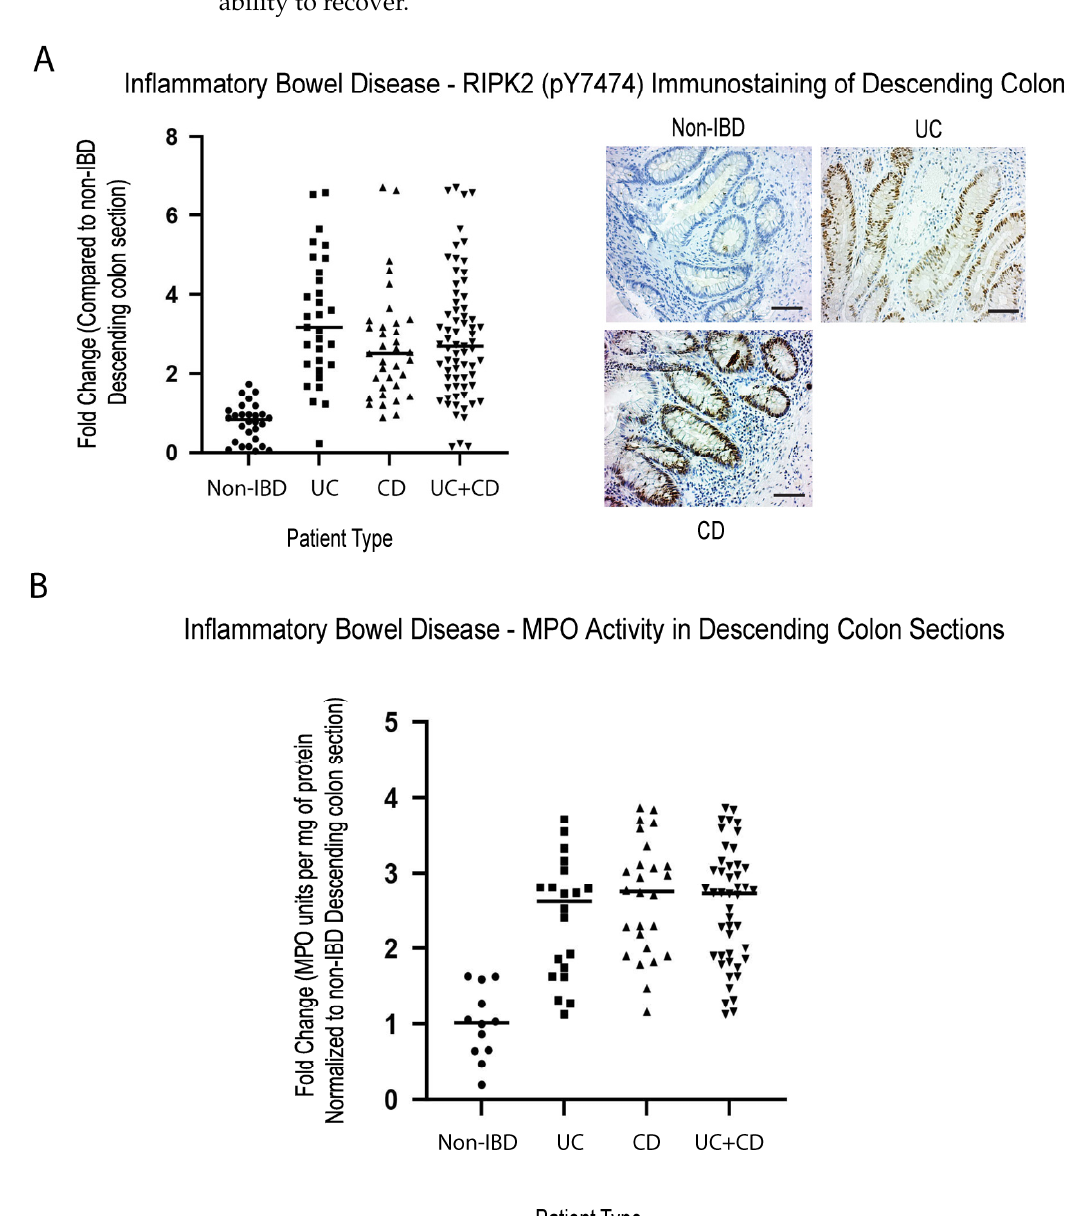
Figure 2. Elevated activity of inflammatory markers (active RIPK2 and MPO) in IBD colonic sections. Immunohistochemical staining for ( A ) RIPK2 pY474, ( B ) myeloperoxidase in descending colon sections of IBD patients reveals elevated activity of the pathogen recognition receptor (NOD2) associated kinase RIPK2, and a common molecular marker of inflammation, MPO. For ( A ), left panel, summary of fold change in IHC staining of tissue sections; right panel, representative sections for each patient category. For ( A ), p value < 0.001 for difference between UC/CD/UC+CD vs. non-IBD (n = 30 for non-IBD and 32 for UC, 35 for CD, and 67 for UC+CD). For ( B ), p value < 0.001 for difference between UC/CD/UC+CD vs. non-IBD (n = 12 for non-IBD and 21 for UC, 29 for CD, and 50 for UC+CD).